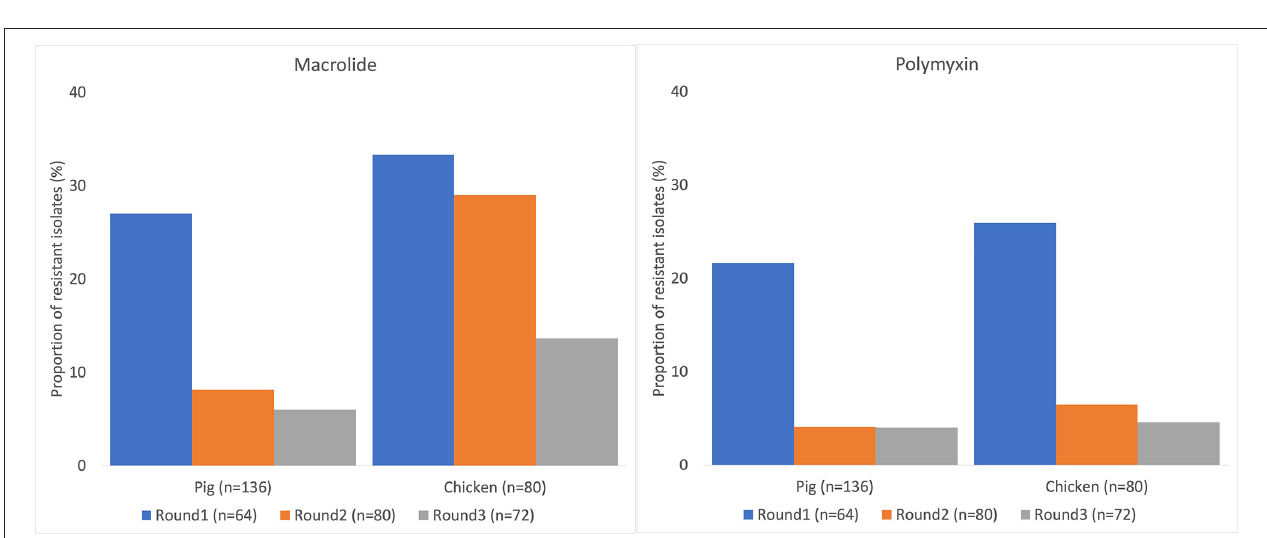
FIGURE 3 | Antimicrobial resistance in non-typhoidal Salmonella in pig and chicken samples collected from five provinces in Vietnam for 20 antimicrobials, 2017–2019.